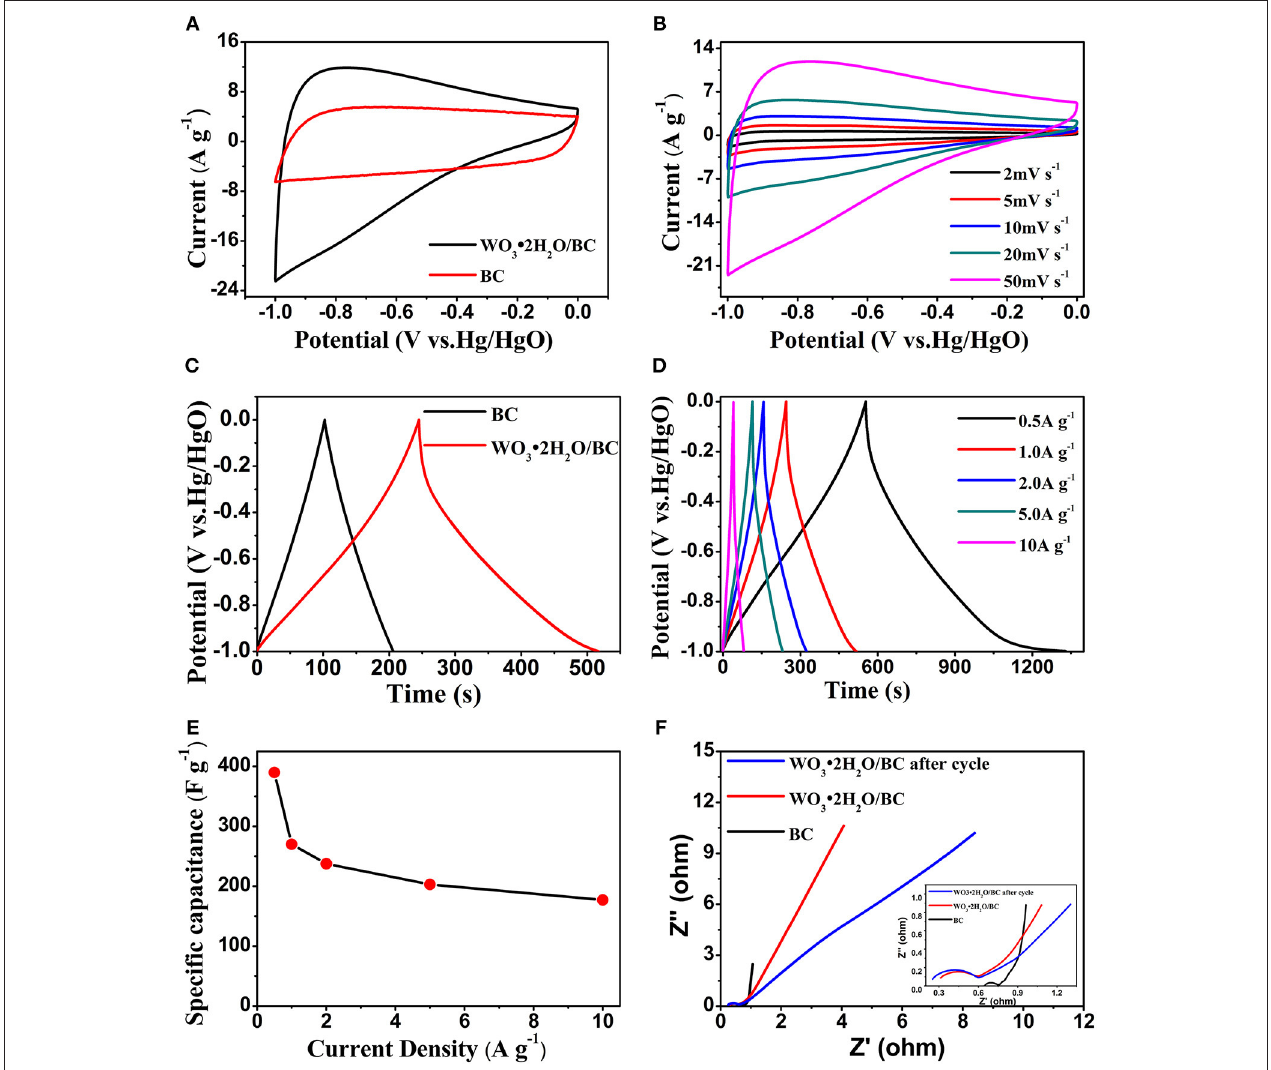
FIGURE 5 | (A) The CV curves of BC and WO 3 · 2H 2 O/BC electrodes at a scan rate of 50mV s − 1 . (B) The CV curves of the WO 3 · 2H 2 O/BC electrode at different scan rates. (C) GCD curves of BC and WO 3 · 2H 2 O/BC electrodes at a current density of 1A g − 1 . (D) GCD curves of the WO 3 · 2H 2 O/BC electrode at different